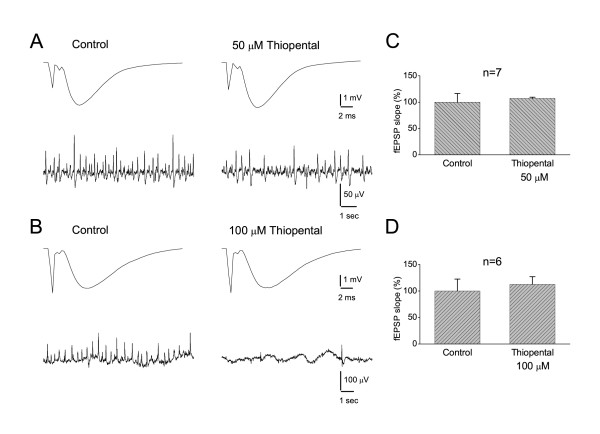
Thiopental did not affect fEPSPs. A-B. Evoked fEPSPs from CA1 st. radiatum (upper traces, averages of ten sweeps) and continuous records of SPW-Rs from CA1 st. pyramidale (lower traces) obtained in normal medium (left panels) and in medium containing 50 or 100 μM of thiopental (right panels). fEPSPs and spontaneous activity were simultaneously recorded from two neighboring slices in "A" and from the same slice in "B". Note that the drug did not affect fEPSPs despite its suppressive effect on spontaneous activity. C-D. Grouped data of fEPSP slope for the two concentrations of thiopental. The drug did not significantly change the slope of fEPSP at any concentration.